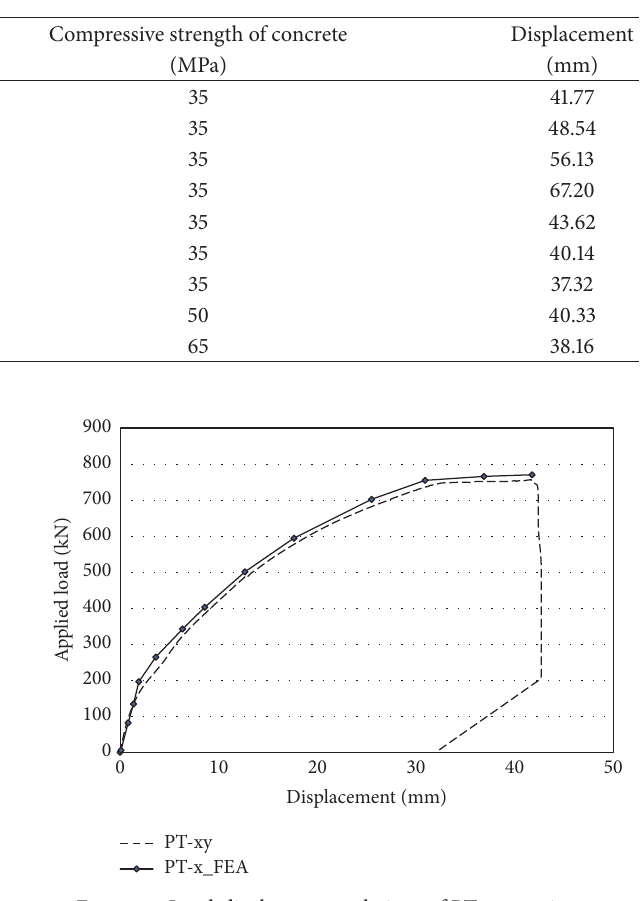
Table 3: Analytical dimensions and results of parametric study.